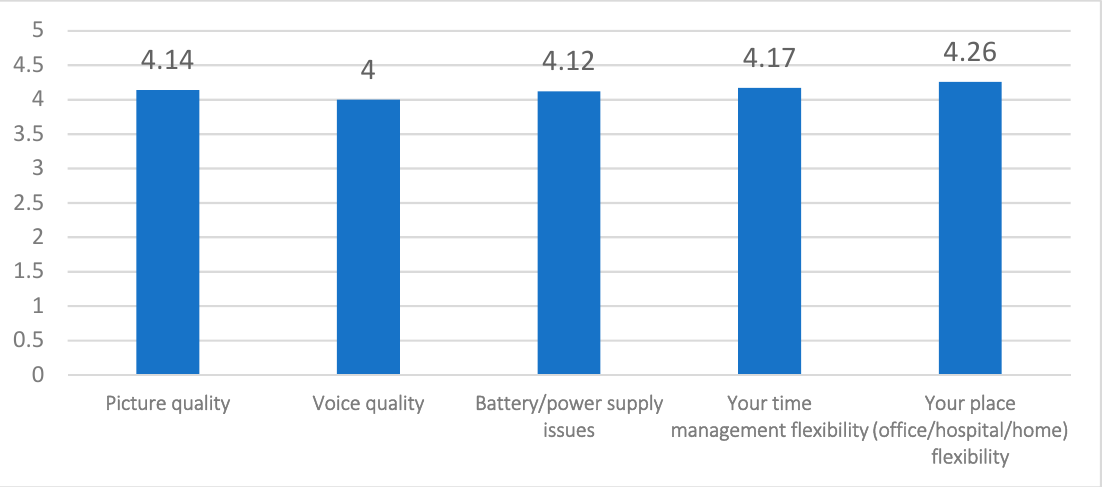
Figure 5. Faculty members’ (mean) satisfaction rate with virtual interviews domains of performance (maximum 5).